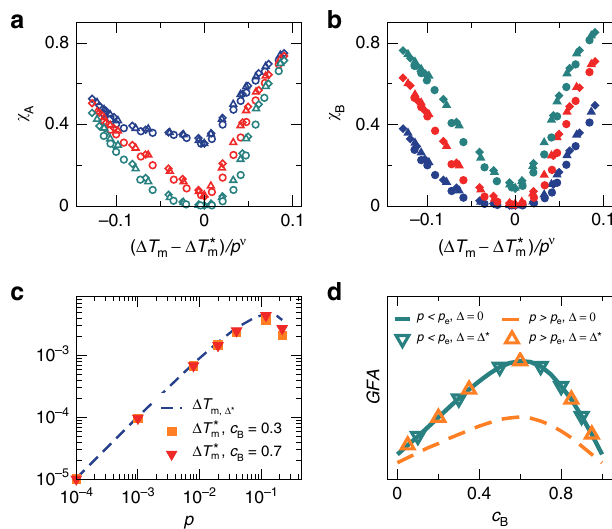
Fig. 5 Particle composition dependence. Here we show results of harmonic systems with γ = 1.4. a , b Scaling collapse of χ A ( Δ T m ) and χ Δ T p = 10 − 5 (diamonds), 10 − 4 (triangles), and B ( m ) of solid-like states at 10 − 3 (circles) quenched via the rate ~ κ ¼ 1 : 22 ´ 10 (cid:2) 6 . Δ T (cid:3) is the value of m Δ T χ χ ν ≈ 1.02. Three values of c m at which A and B reach the minimum, and B are presented: 0.3 (blue), 0.5 (red), and 0.7 (green). c Comparison of ð p Þ for c = 0.3 and 0.7 and Δ T ð p Þ with melting temperature gaps Δ T (cid:3) B m ; Δ (cid:3) m Δ = Δ * de fi ned in Eq. (14). They agree well, as shown in Fig. 4e for c = 0.5. B d Schematic plot of the GFA against c B on both sides of p e de fi ned in Eq. (13) and at Δ = 0 and Δ